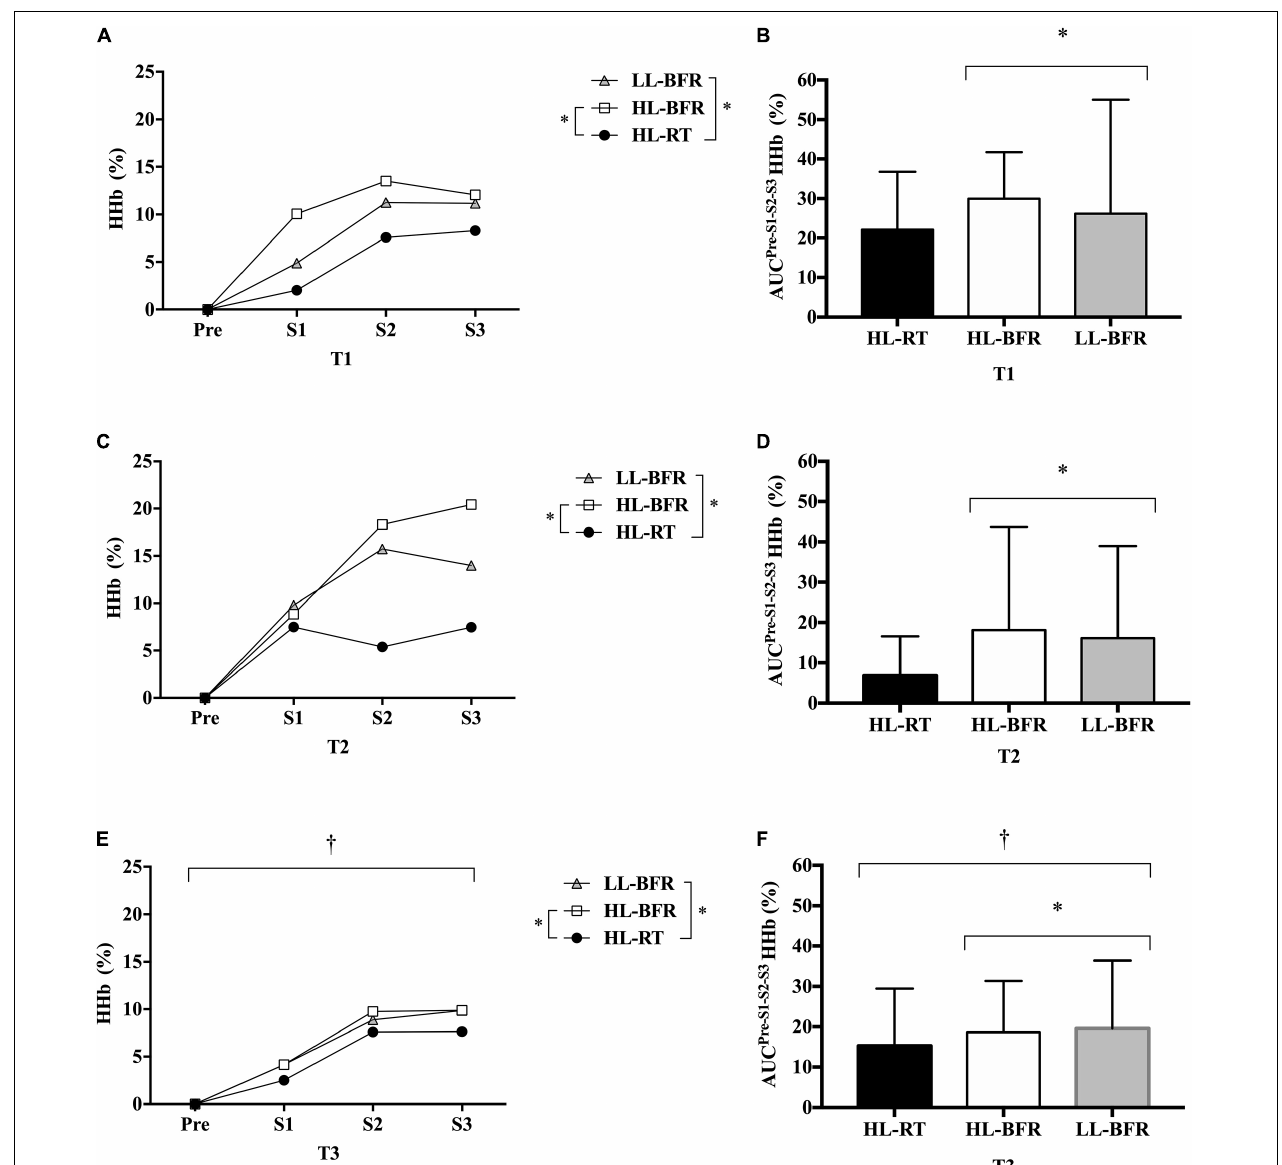
FIGURE 3 | Normalized deoxygenated hemoglobin ([HHb]) values from the resistance training session (Pre [Before the beginning of the exercise], set 1 [S1], set 2 [S2], and set 3 [S3]) at baseline (T1, A ), after 5 (T2, C ) and 10 weeks (T3, E ) for the high-load resistance training (HL-RT), high-load resistance training with blood flow restriction (HL-BFR) and low-load resistance training with blood flow restriction (LL-BFR) protocols. [HHb] values also are reported as area under the curves (AUC) from the entire resistance training session at T1 (B) , T2 (D) , and T3 (F) for the HL-RT, HL-BFR, and LL-BFR protocols. ∗ Significantly different from HL-RT (main protocol effect, P < 0.04). † Significant different from T2 (main time effect, P < 0.04). Values presented as mean ±